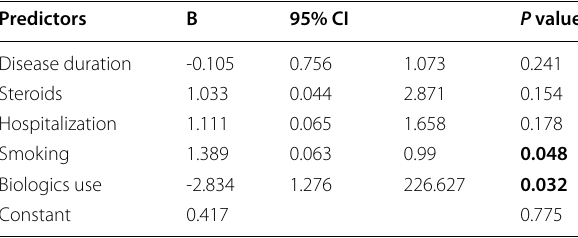
Bold values are significant at P 0.05 ≤ Table 5 Post-COVID-19 syndrome severity in rheumatic disease patients according to vaccination doses received